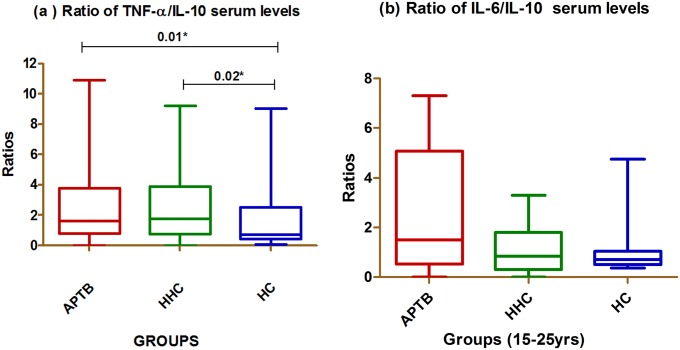
Comparison of cytokines in APTB, HHC and HC categories.(a) Ratio of TNF-α/IL-10 serum levels (b) Ratio of IL-6/IL-10 serum levels. Results are represented as box plot. The threshold for significance was set at p ≤ 0.05. Bars above the plots represent the statistical differences between the groups.